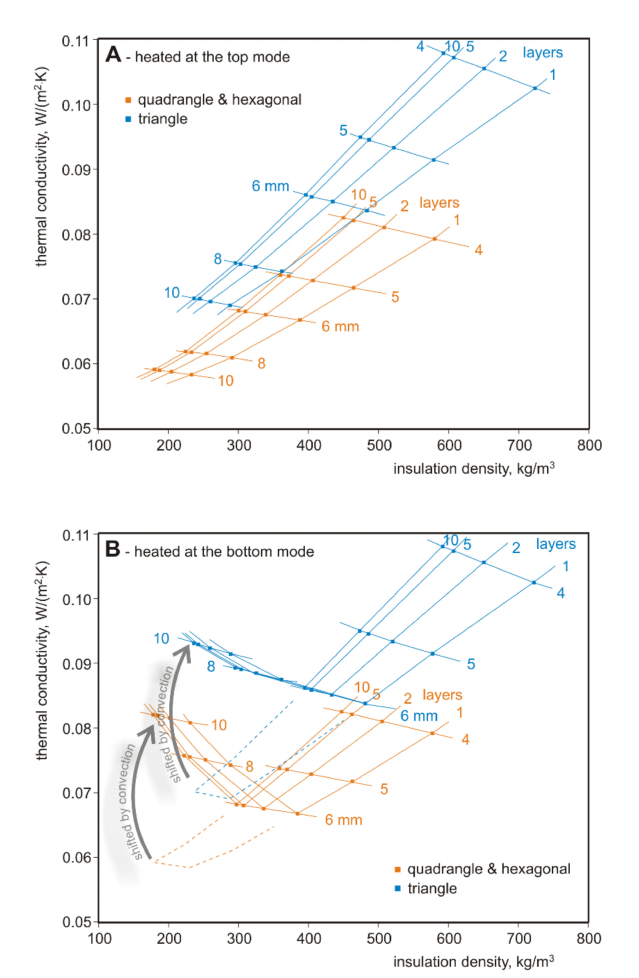
Figure 9. Thermal conductivity in relation to the density of the considered additively manufactured insulation. ( A ) heated at the top mode, ( B ) heated at the bottom